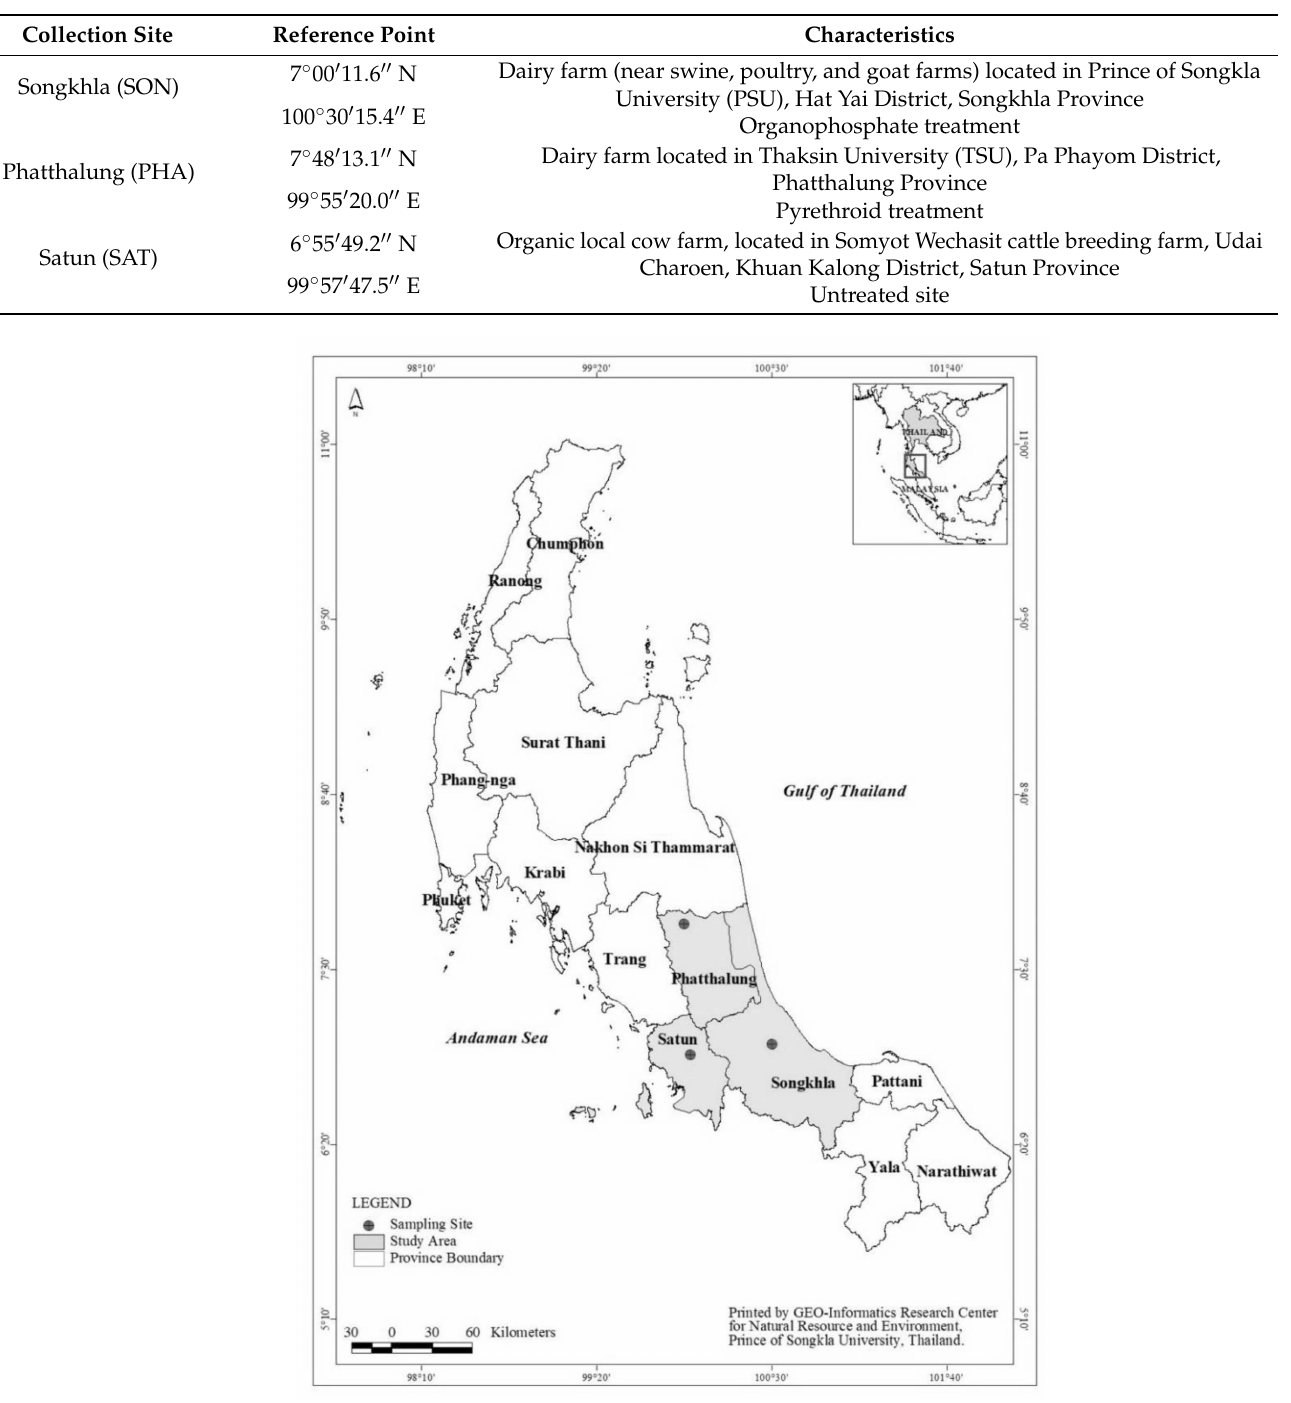
Table 1. The collection sites of stable flies located in three provinces: Songkhla (SON), Phatthalung (PHA), and Satun (SAT). The associated characteristics and insecticide use are summarized.